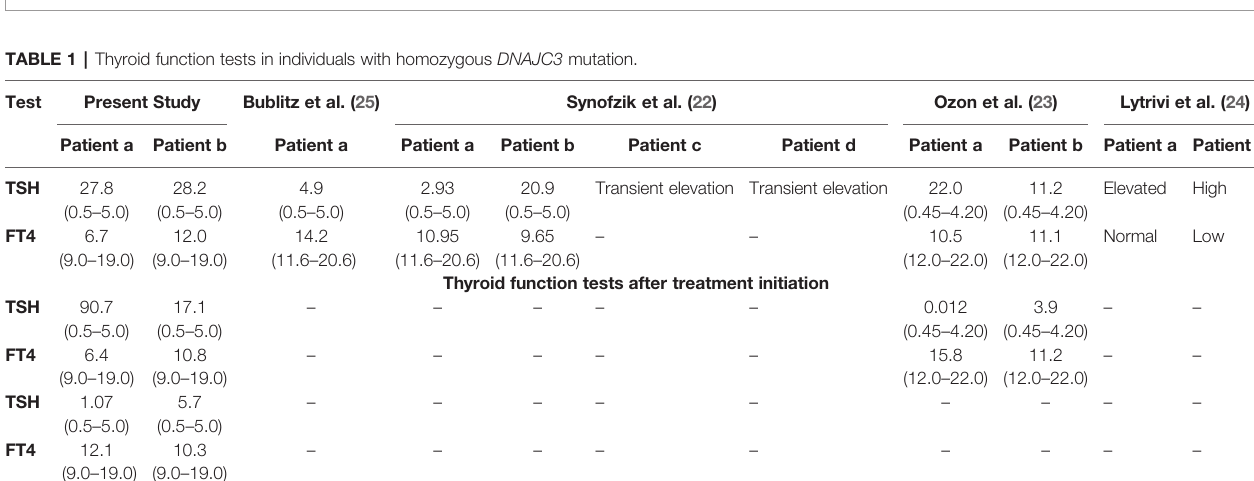
FIGURE 1 | Family pedigree of patients A and B.